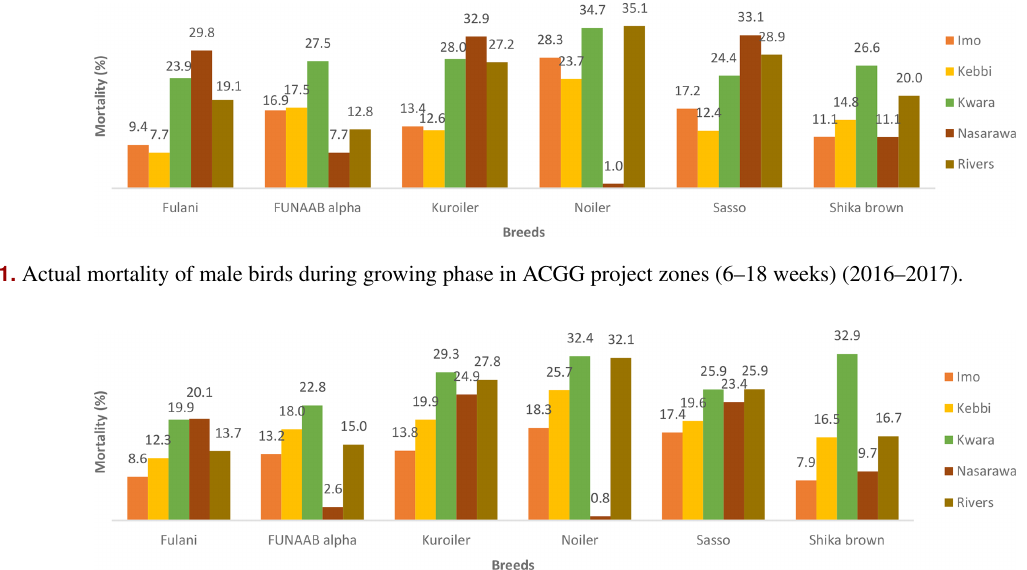
survival ability (0.699), having more birds at risk of